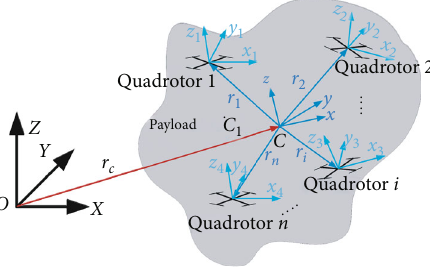
Figure 2: The cooperative transportation